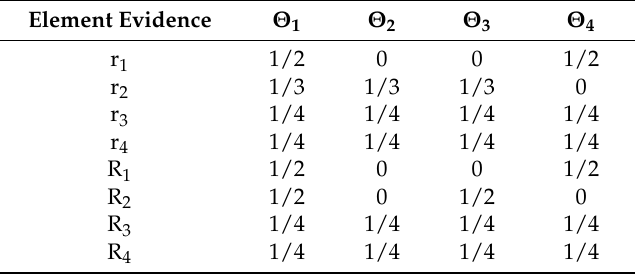
Table 4. Basic Probability Assignment (BPA).